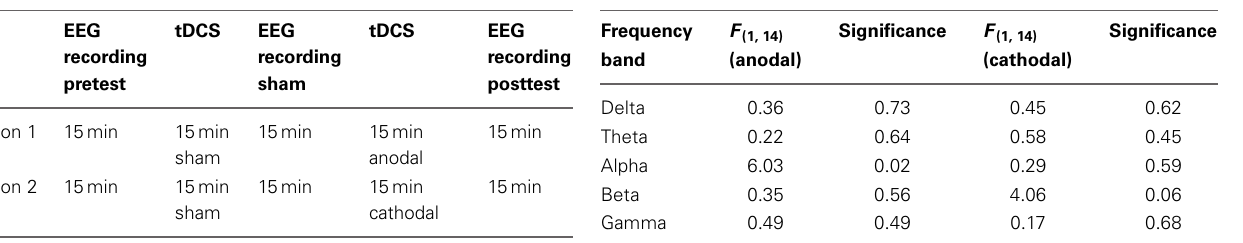
Table 1 | Sequence of stimulation and recording. Table 2 | Effects of stimulation by frequency band.